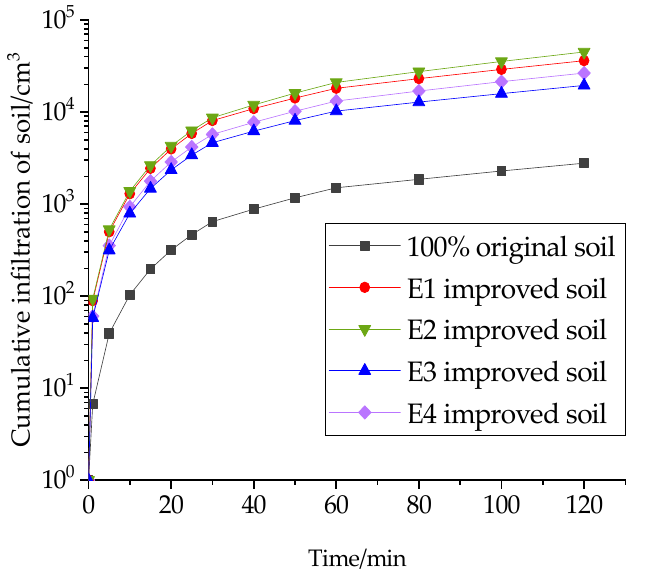
Figure 6. Effect of the interweaving of ameliorants and structural amendments on cumulative soil infiltration.